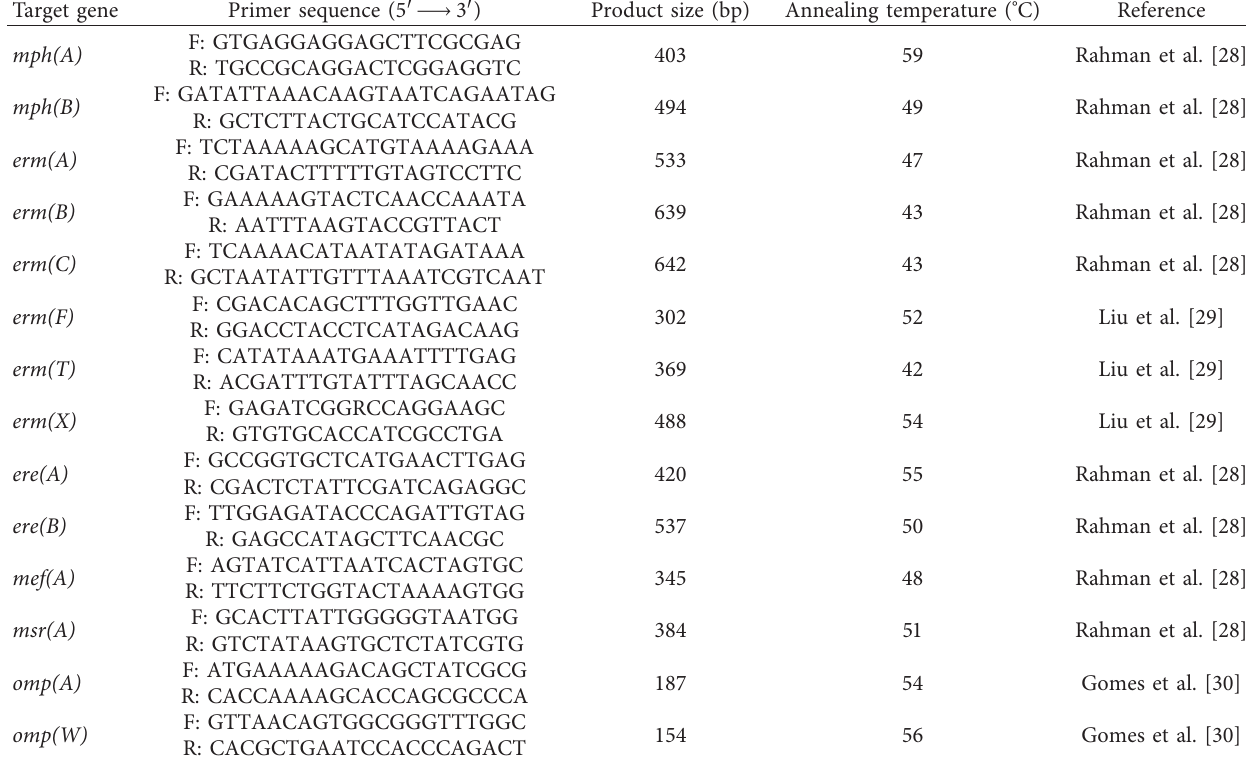
Table 1: Primer sequences.